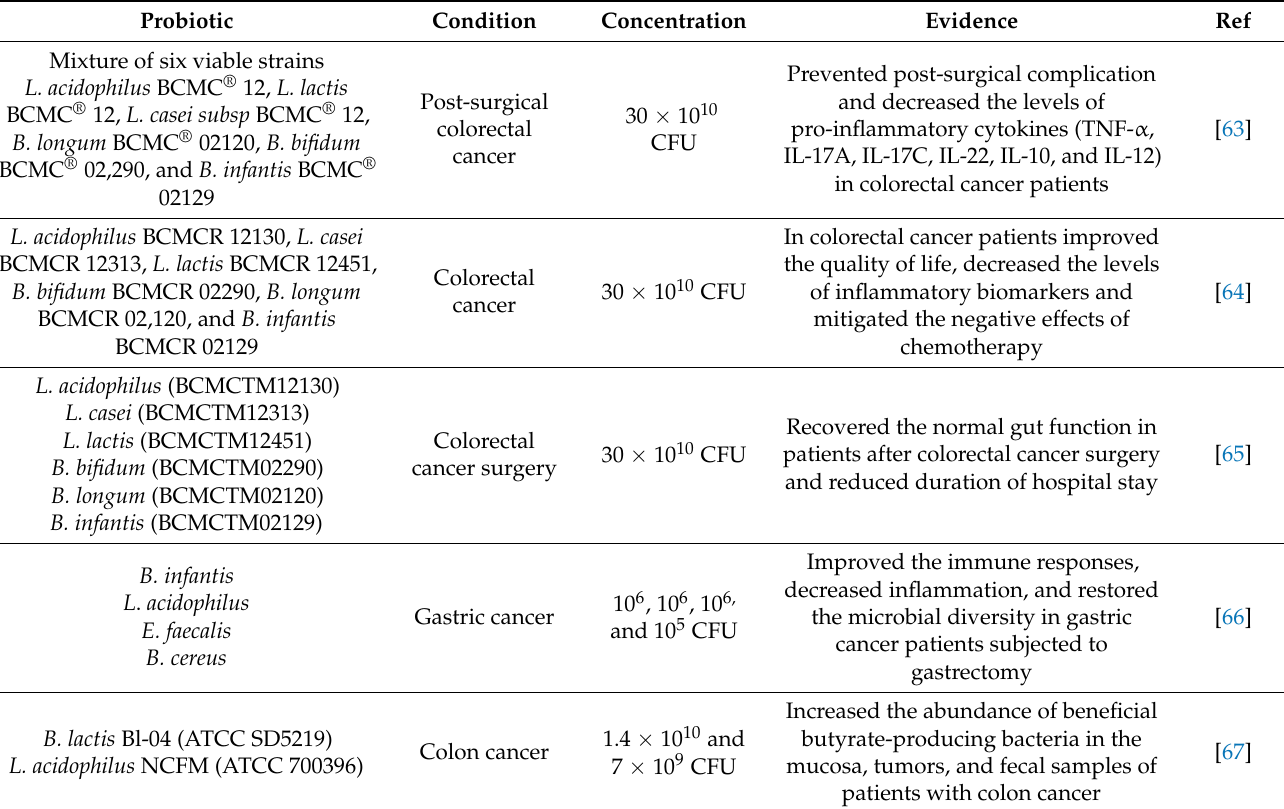
Table 3. Common probiotics used in oncology